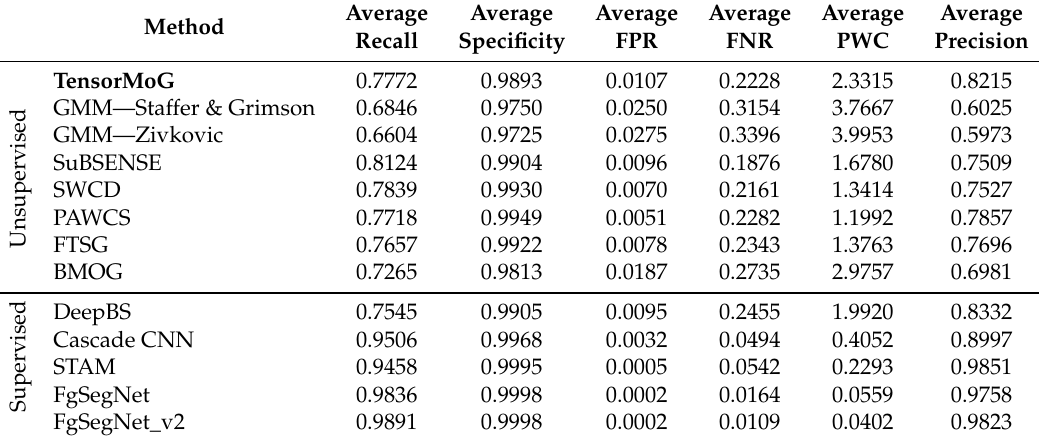
Table 3. Result of quantitative evaluation on CDnet 2014